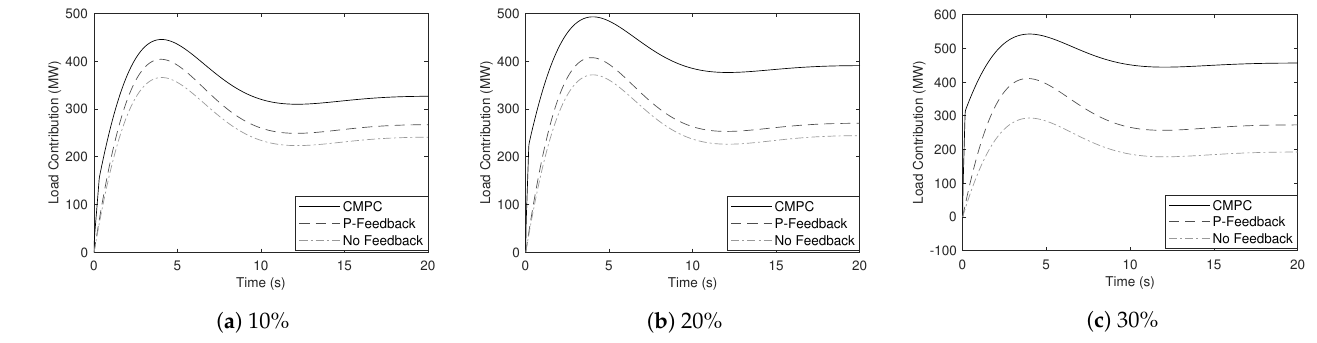
Figure 8. Load response under a 2GW power loss. The output voltage of the SST is shown in Figure 9. For the “no feedback” case, the voltage magnitude is left constant as no SST integration is considered in this particular scenario. In the case of proportional control feedback, the voltage is proportional to the frequency in the system. Meanwhile, in the incorporation of the CMPC-based controller, the control action drives the voltage directly to the lower possible value within the grid code limits, allowing a much faster and effective response.